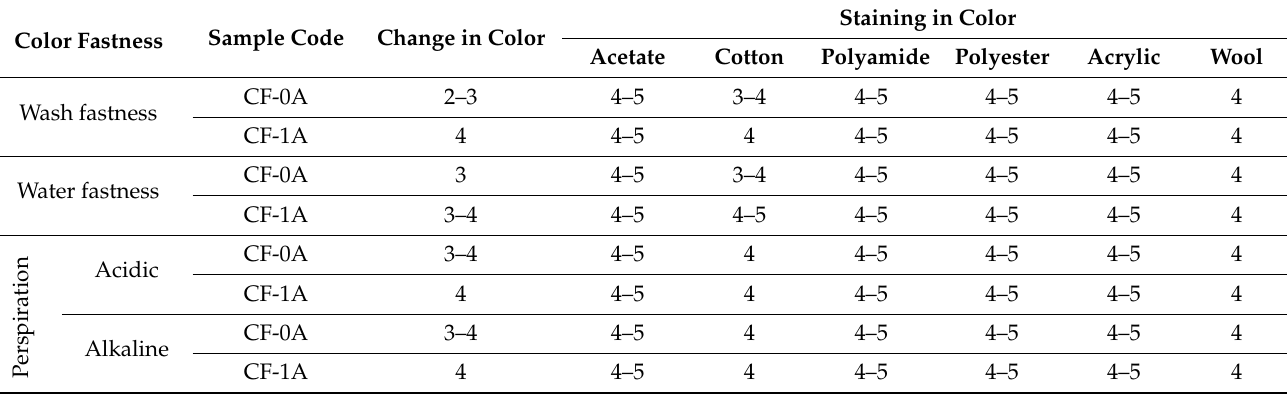
Table 7. Color fastness to wash, water, and perspiration.